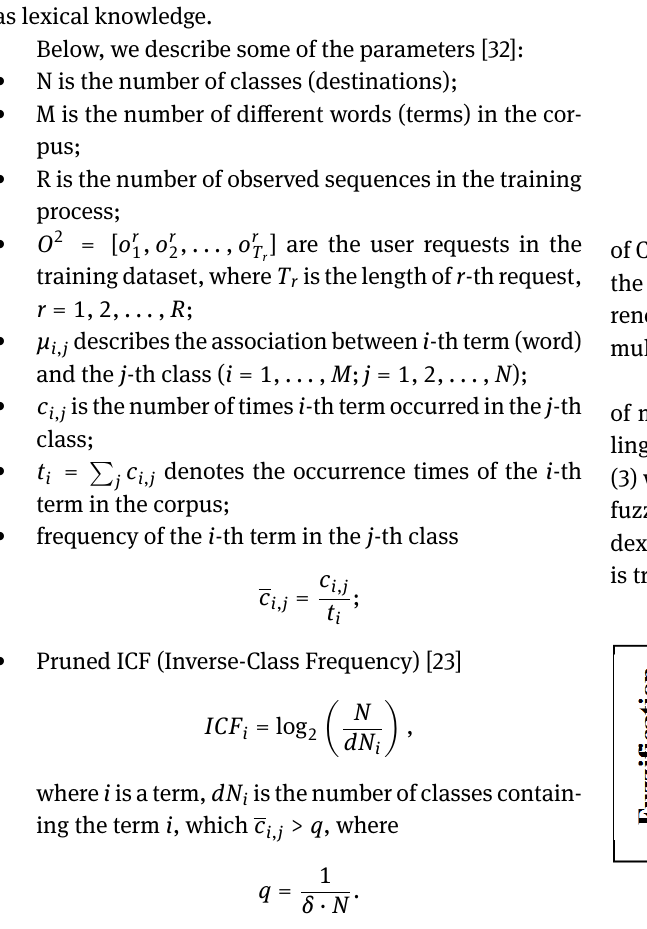
Figure 2: The structure of MANN in